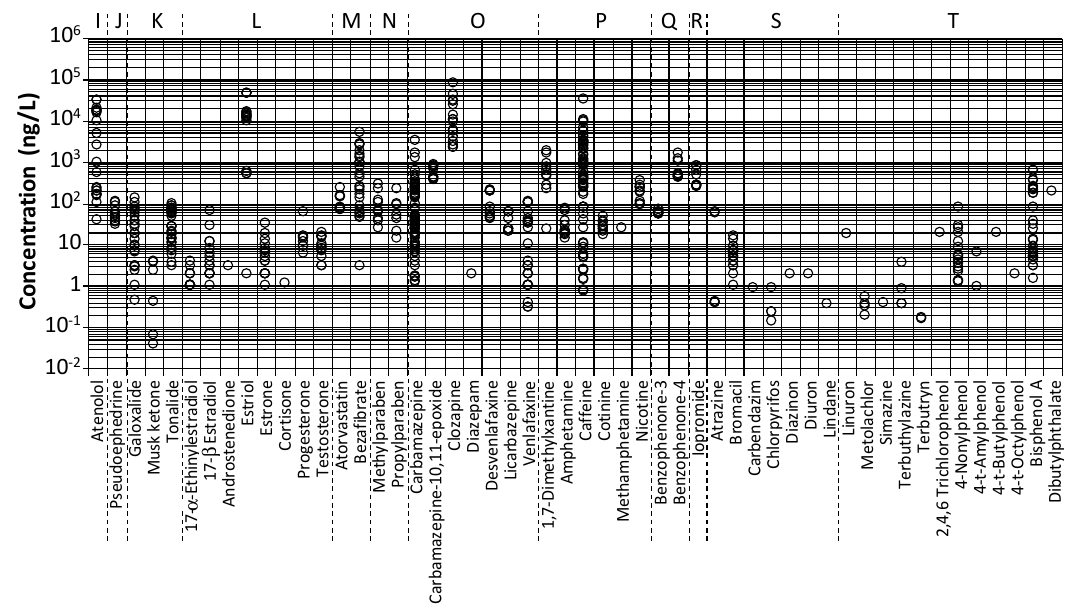
Figure 9. Observed concentrations of micropollutants belonging to classes ( I ) (Beta-blockers), ( J ) (Drug precursors), ( K ) (Fragrances), ( L ) (Hormones), ( M ) (Lipid regulators), ( N ) (Parabens), ( O ) (Psychiatric drug), ( P ) (Stimulants), ( Q ) (UV filters), ( R ) (X-ray contrast media), ( S ) (Pesticides), and ( T ) (Plasticizers) in surface water in the reviewed studies referring to South Africa. Data from: [24–26,43,47–49,54,55,58–60].